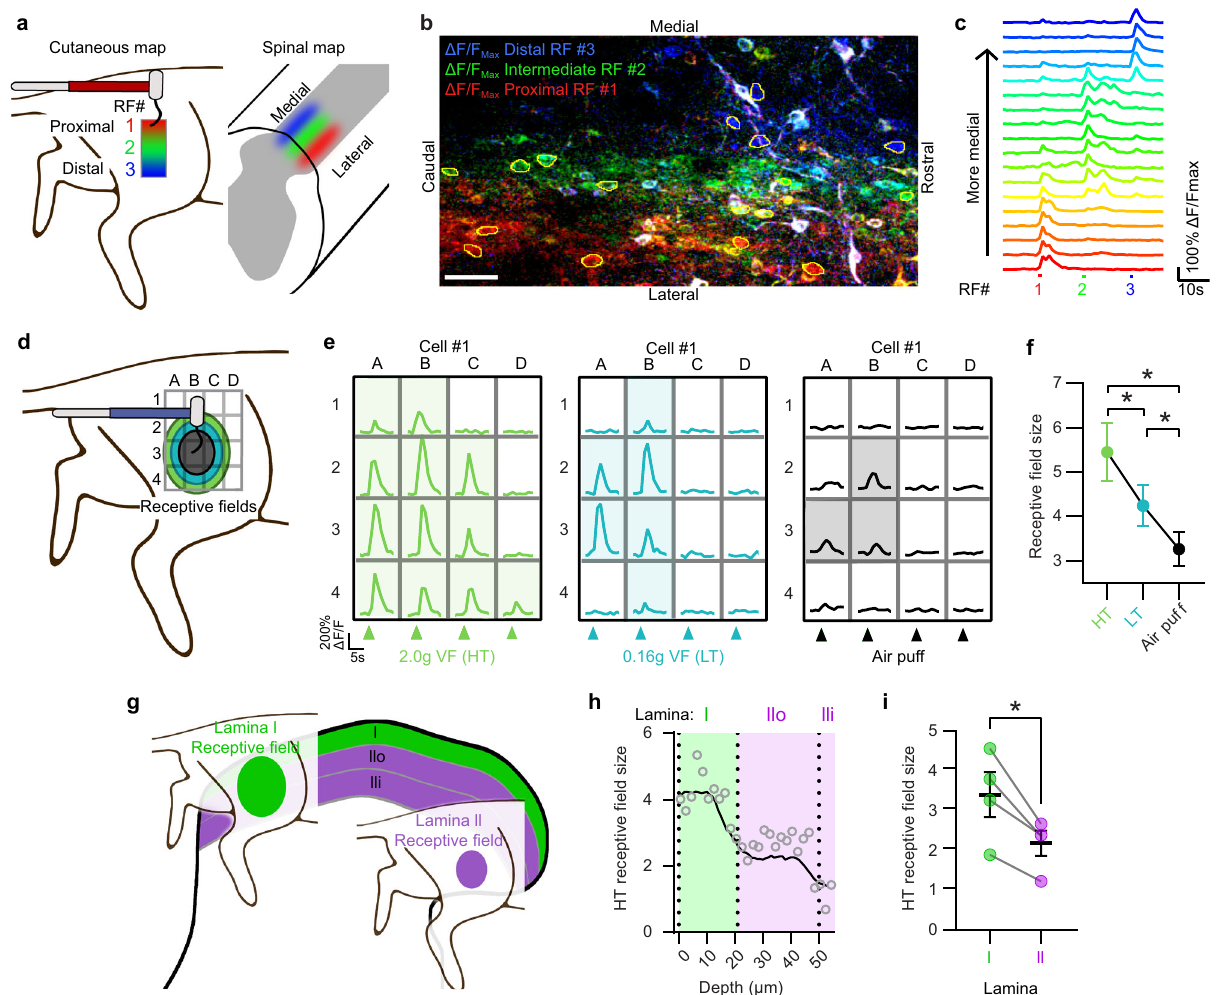
Fig. 3 | Receptive fi elds in SDH are shaped by somatotopy, modality, and relative dorso-ventral position. a Schematic illustrating proximal-distal somato- topy. b Field of view in the super fi cial SDH showing maximum intensity responses after LT stimulation pseudo-colored to each of the indicated receptive fi elds (RF) in a : red, proximal; green, intermediate; blue, distal (scale bar, 50 µ m). N =4 animals. c , Δ F/F Ca 2+ traces from circled cells in b , showing responses to stimulation at the three indicated RFs, serially stimulated from proximal to distal. Traces are arranged bytheirsomaticmedio-laterallocation. d SchematicillustratingRFsizesfordifferent mechanical stimuli: HT, green; LT, blue; and air puff, black. e Representative Δ F/F